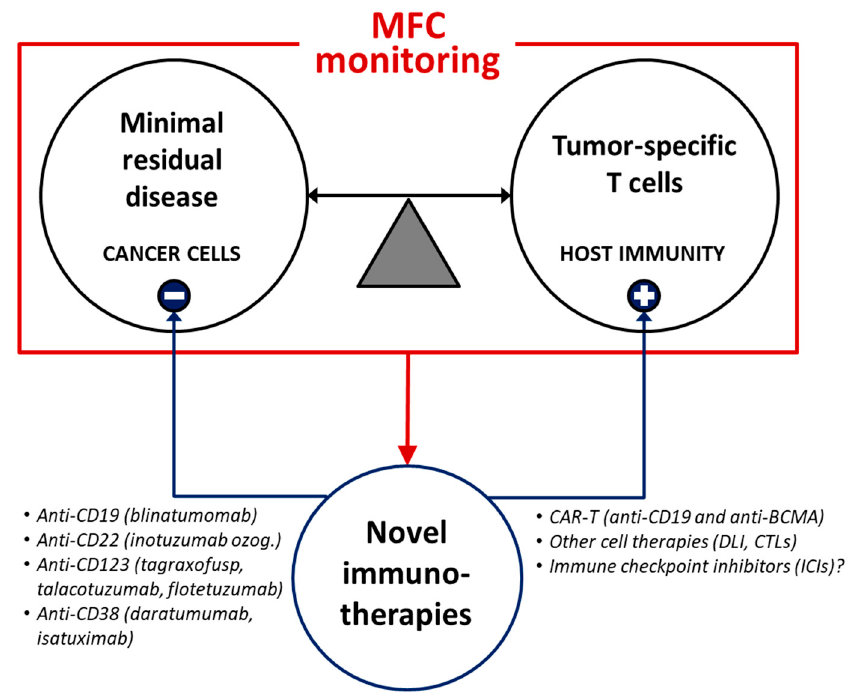
Figure 2. MFC applications may guide early immunotherapeutic strategies during the follow-up of hematologic malignancies. Advanced MFC-based monitoring of both MRD and protective immunity may contribute to the rational use of innovative target therapies (such as monoclonal antibodies, cell therapies and other immunomodulatory treatments). DLI = donor lymphocyte infusion. CTLs = cytotoxic T lymphocytes. BCMA = B cell maturation antigen.